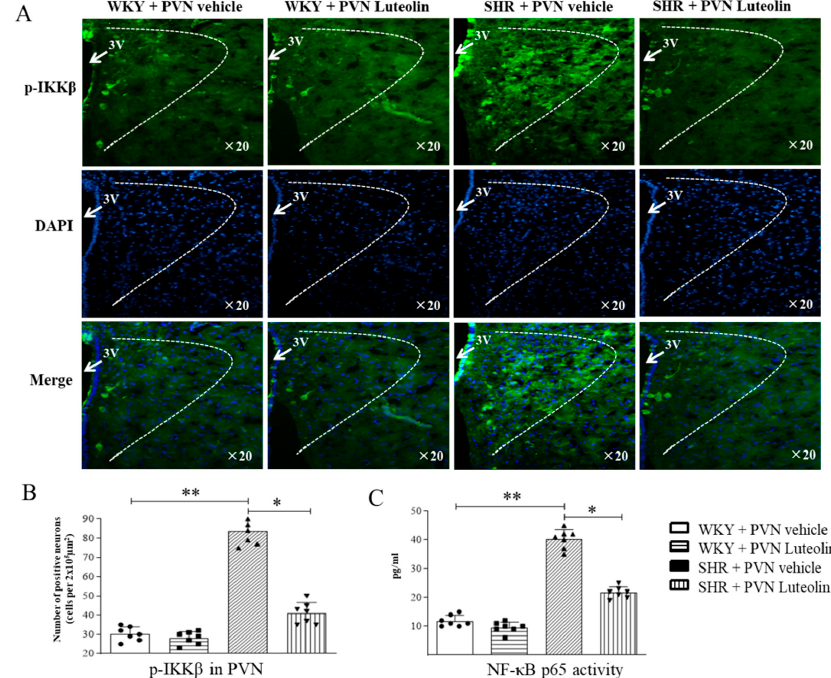
Figure 5. Effects of PVN luteolin on NF- κ B in PVN. ( A ) A representative immunofluorescence image showing p-IKK β positive cell (green fluorescence). ( B ) Quantification of p-IKK β positive cell count in PVN of SHRs and WKY rats, with or without luteolin treatment. ( C ) Statistical analysis of NF- κ B activity in PVN of SHRs and WKY rats treated with luteolin or aCSF. Values are the mean ± SEM from 7 rats/group. * p < 0.05, ** p < 0.01. 3V, third ventricle. 3.6. Luteolin Reduced the Production of TH in the PVN of SHRs Immunofluorescence staining shows that hypertension in SHRs is associated with increased production of TH (Figure 6A,B) in the PVN which was reduced by the chronic infusion of luteolin in SHRs but not in WKY rats.